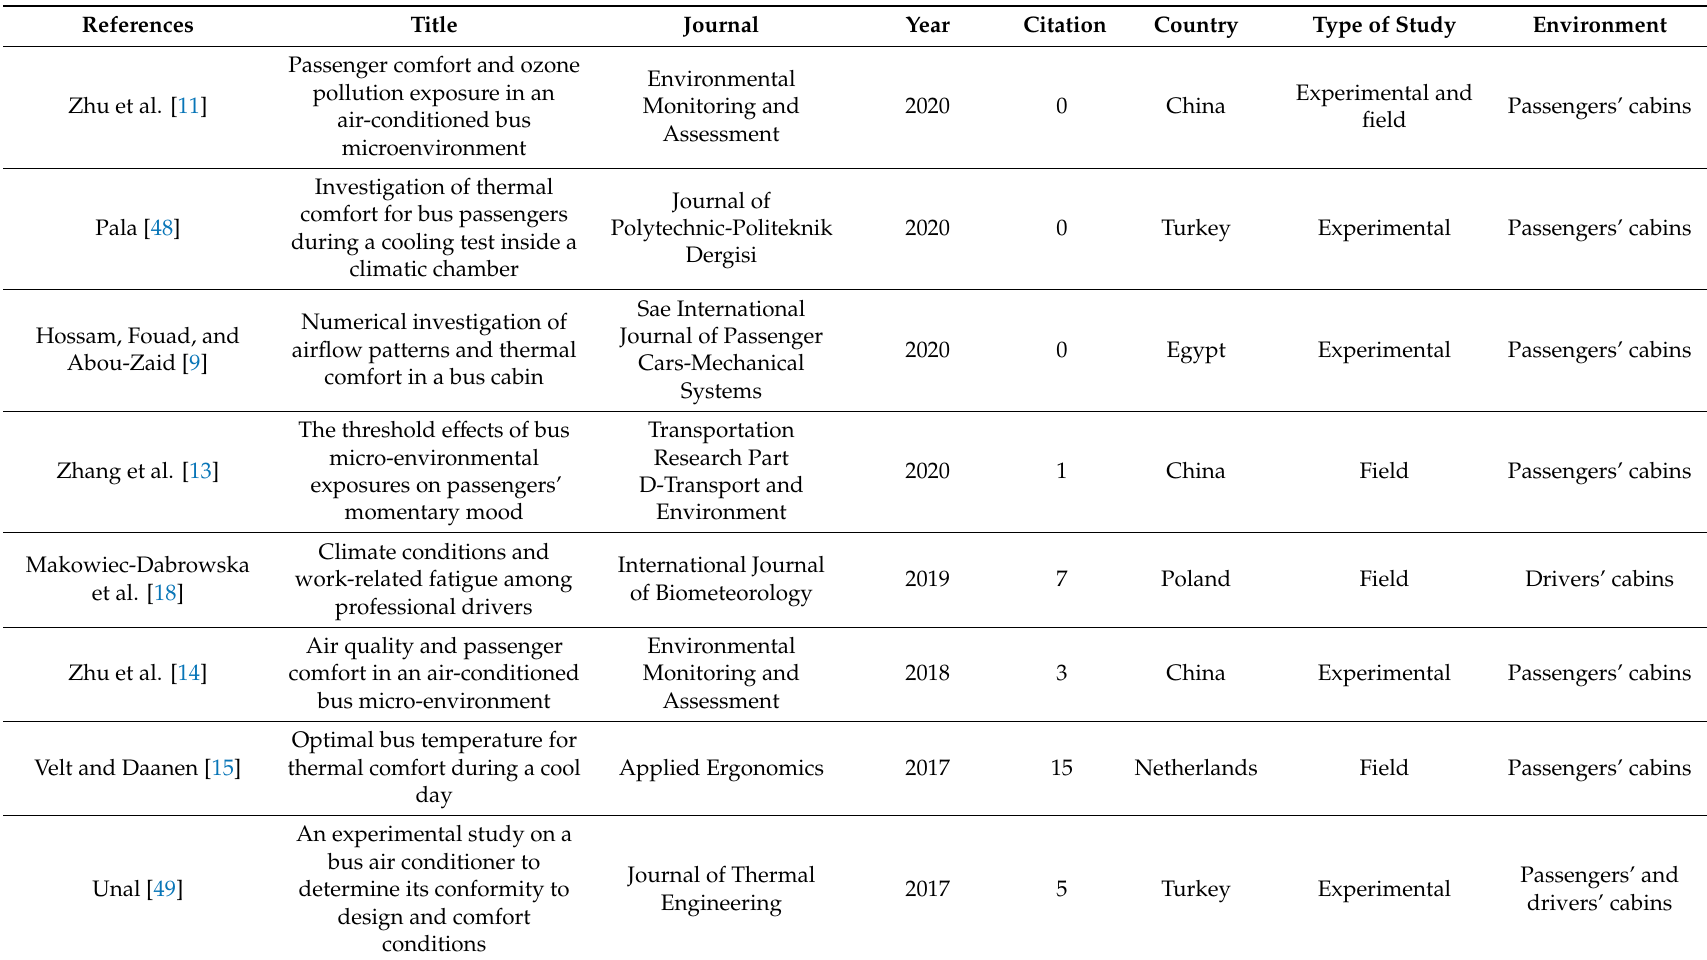
Table 4. Papers included in this